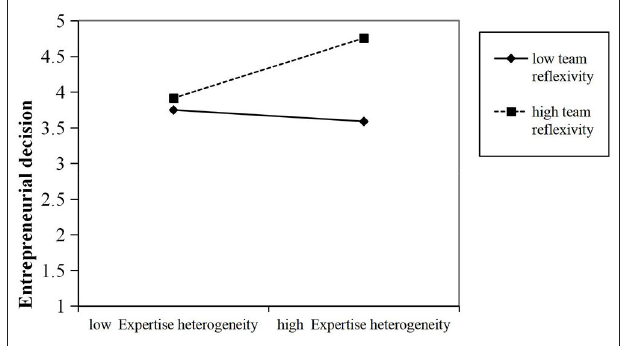
FIGURE 2 | Interaction between expertise heterogeneity and reflexivity on entrepreneurial